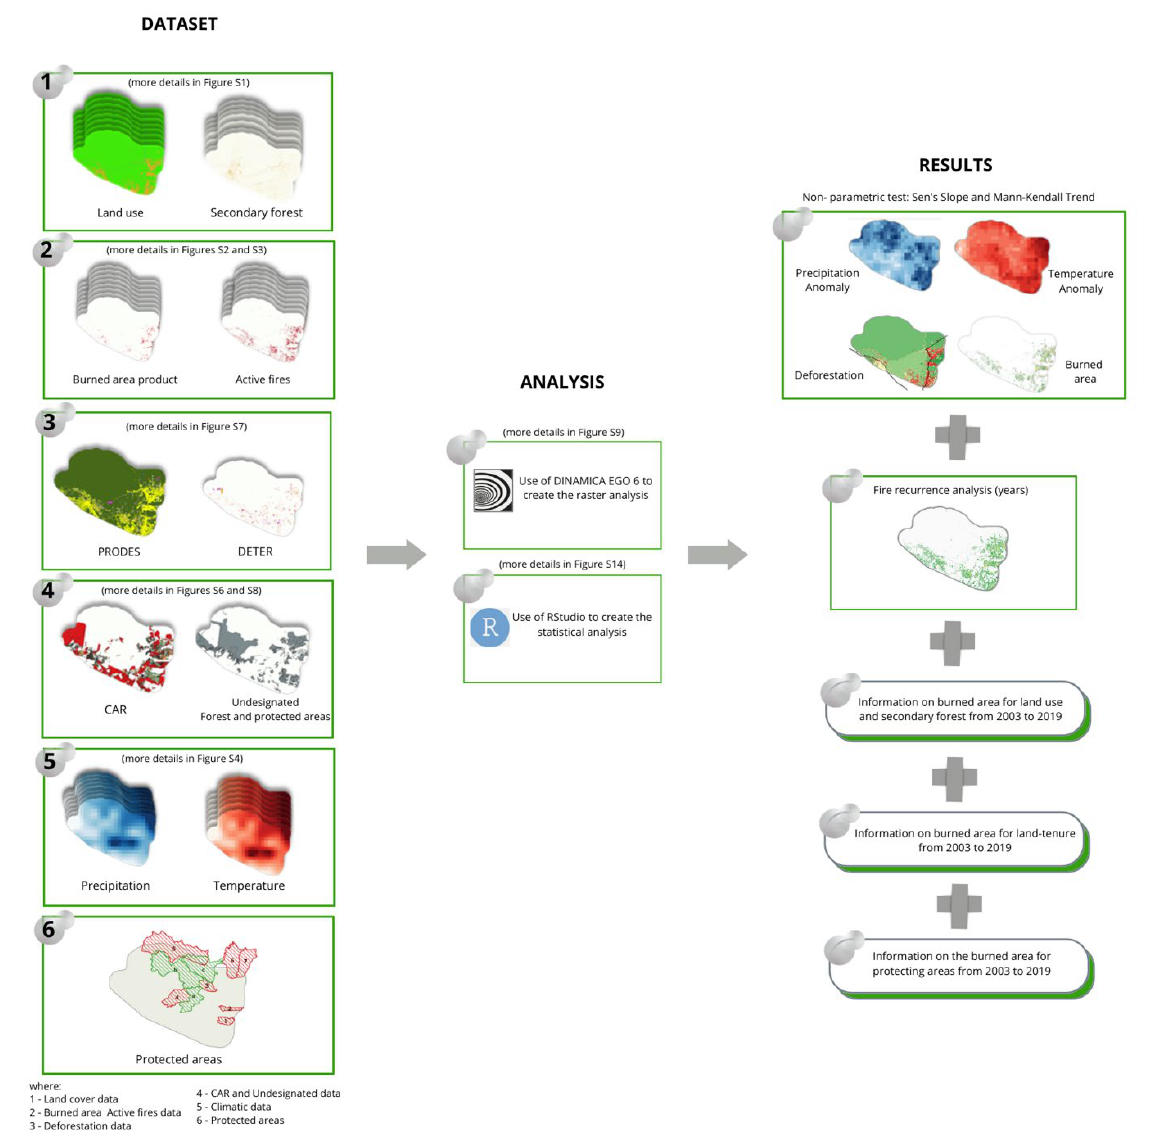
Figure 2. Methodological flowchart of burned area analysis in the study region from 2003 to 2019, divided into three steps: dataset (more details in Figures S1–S8), analysis (ore details in Figures S9 and S14) and results.